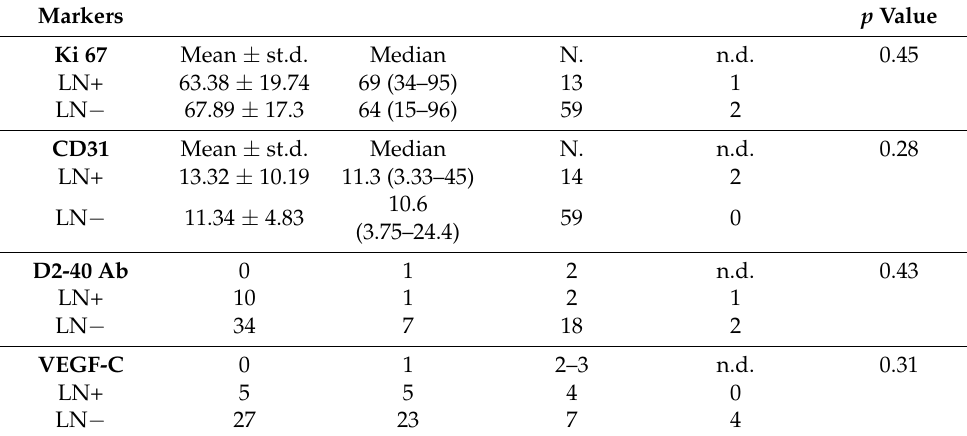
showed a statistically significant increase in cases with adenocarcinoma histotype ( p = 0.04). Table 4. Correlation between proliferation markers and lymph node